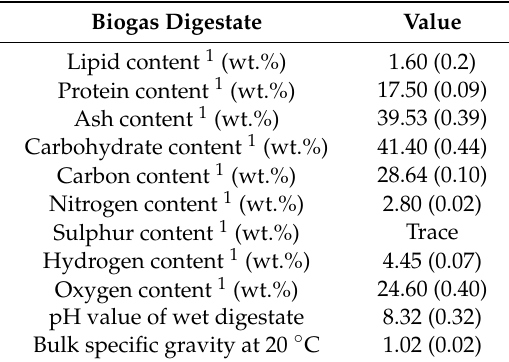
Table 5. Characteristics of digestate